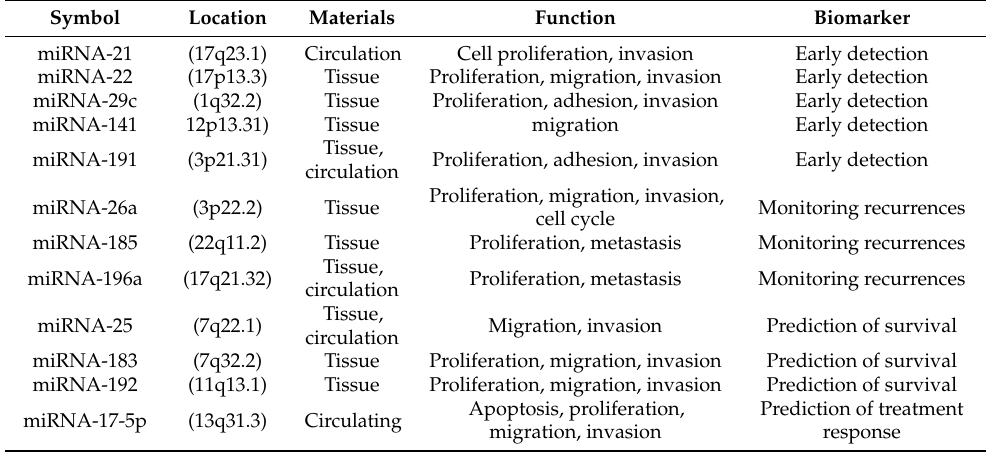
Table 2. microRNAs in gastric cancer